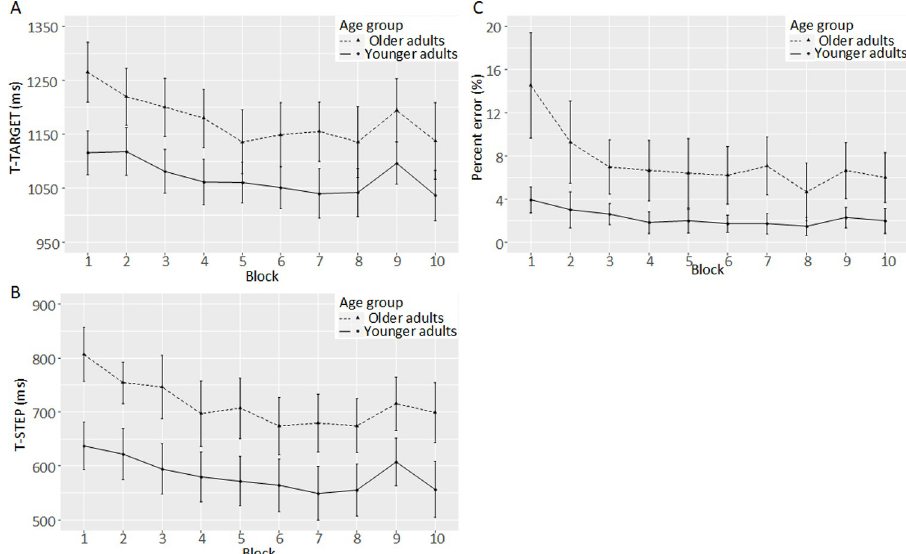
Fig 4. Performance curves of the (A and B) response latencies for the main stepping events and (C) percent error. In the Blocks 1, 2 and 9, the sequence of stimuli was random, while in the remaining Blocks 3 to 8 and 10 the respective target sequence was presented 6 times. T-STEP: time point step onset; T-TARGET: time point step onto pressure- sensitive mat. Error bars represent 95% confidence intervals.